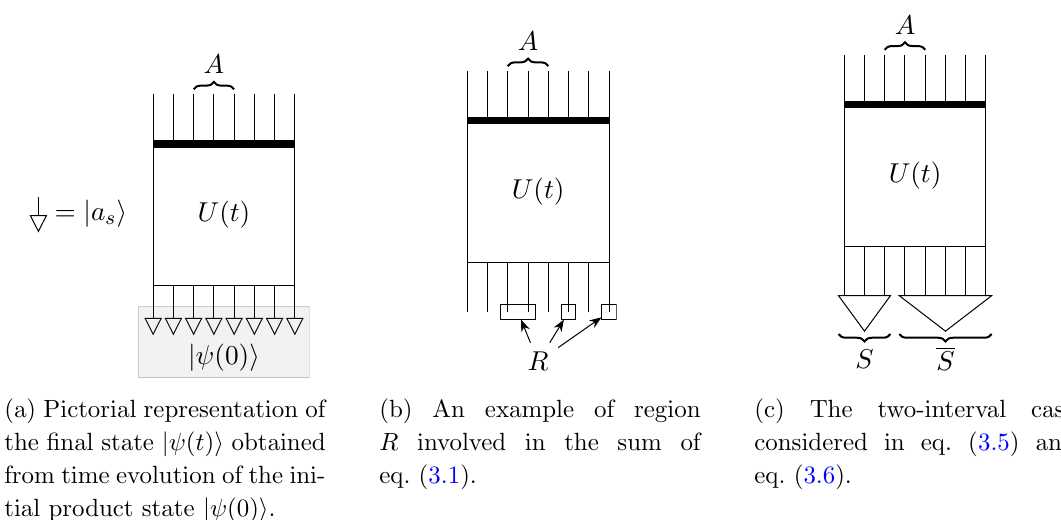
a s is di(cid:11)erent despite being drawn j i